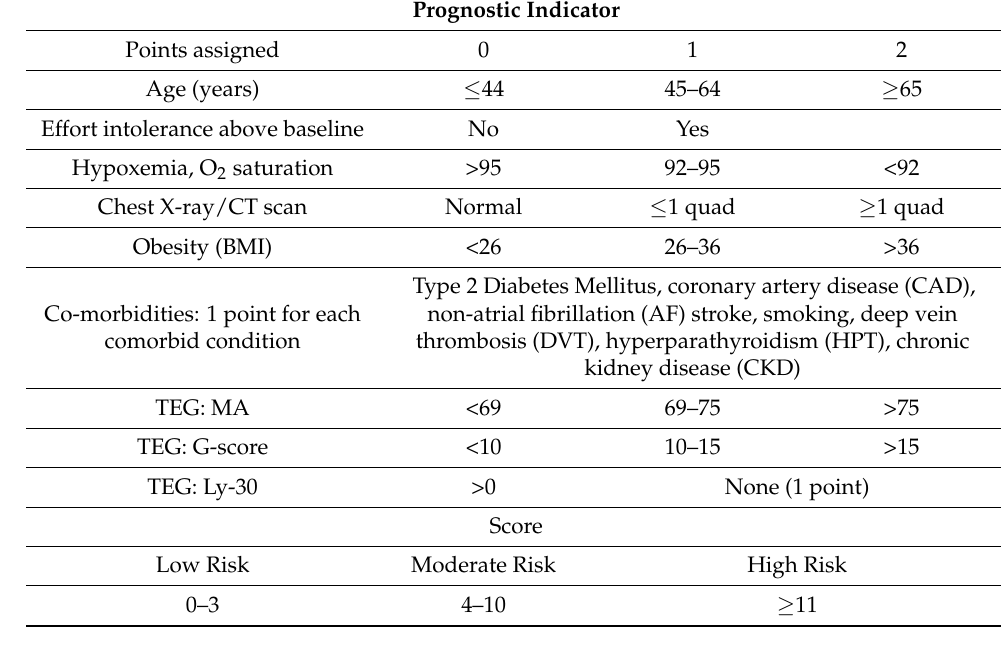
Table 6. A suggested prognostic indicator based on a points system. Prognostic